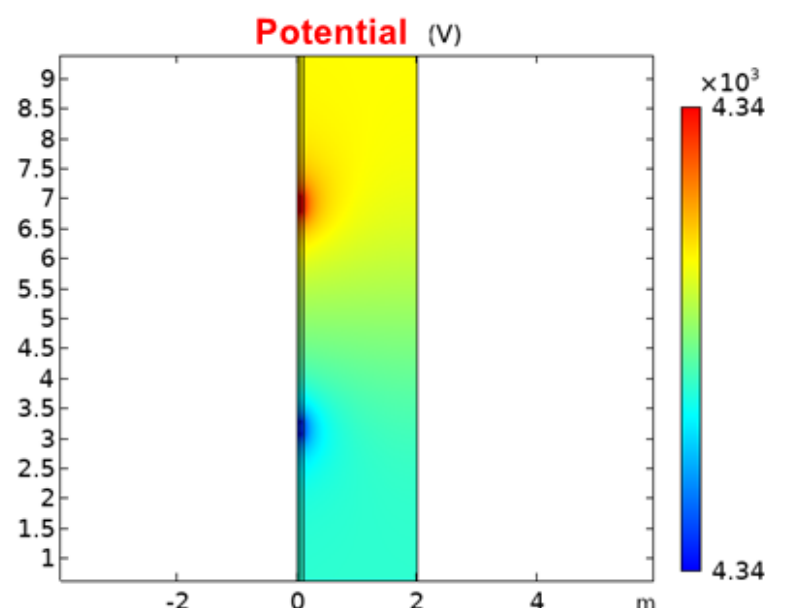
U Ex (cid:0) (1 125) S/m , when the formation conductivity